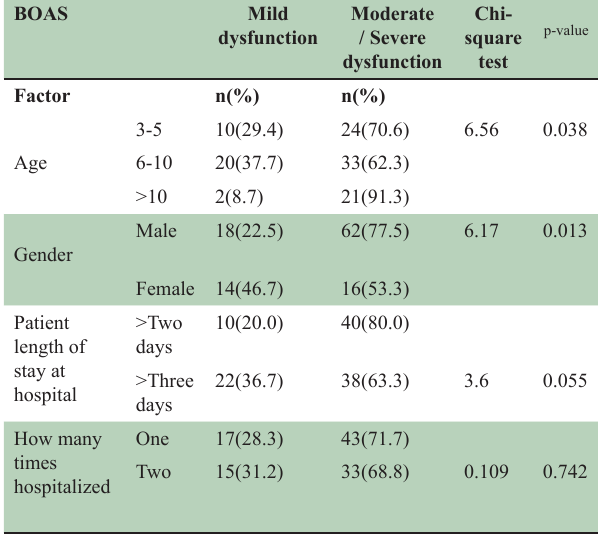
Table-III: Association of Beck oral assessment scale (BOAS) with age, gender, Patient length of stay at the hospital, and how many times